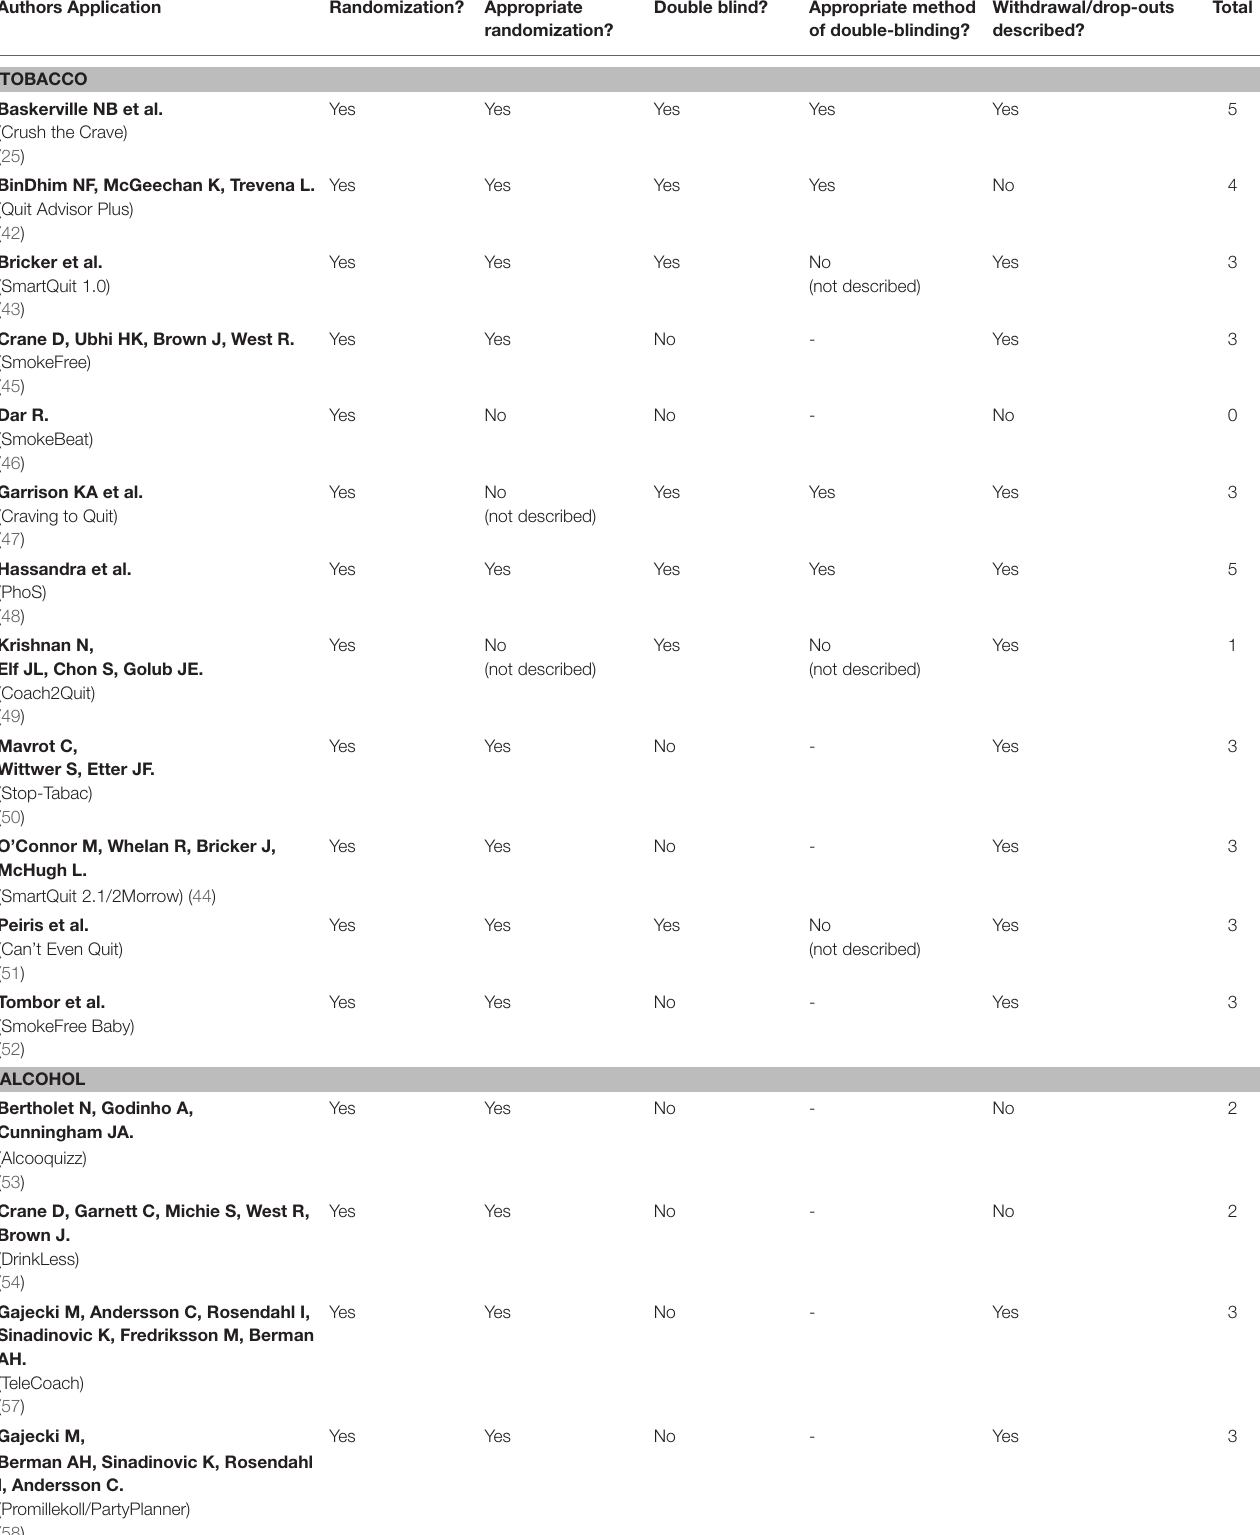
TABLE 5 | Bias risk assessment- JADAD score (ranged by addictive disorder). Authors